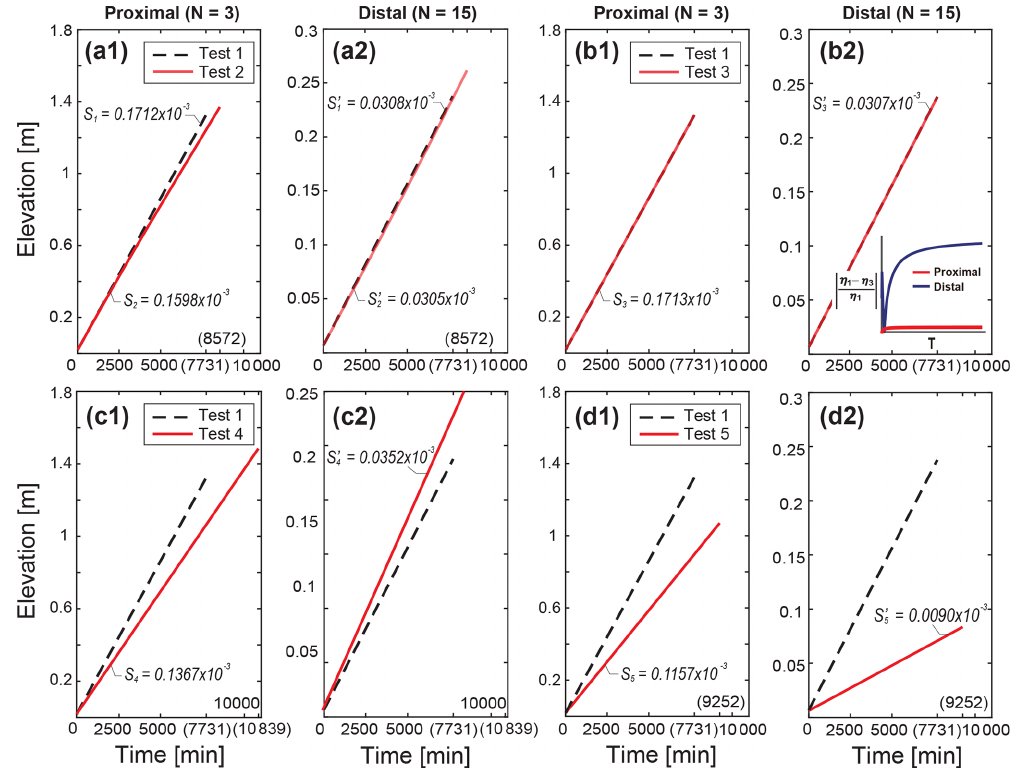
Figure 4. Time series of levee elevations at the proximal ( N = 3, x = 30m) and distal ( N = 15, x = 150m) locations (solid red lines) against the results of Test 1 (dashed black lines) marked with each simulation time, T in parenthesis (Table 1). At each location, the scales of the two y-axes differ by (a) up to 1.8m for the proximal and (b) 0.25m for the distal locations. In (b) , we additionally plot the normalized ratio of elevation differences between Tests 1 and 3